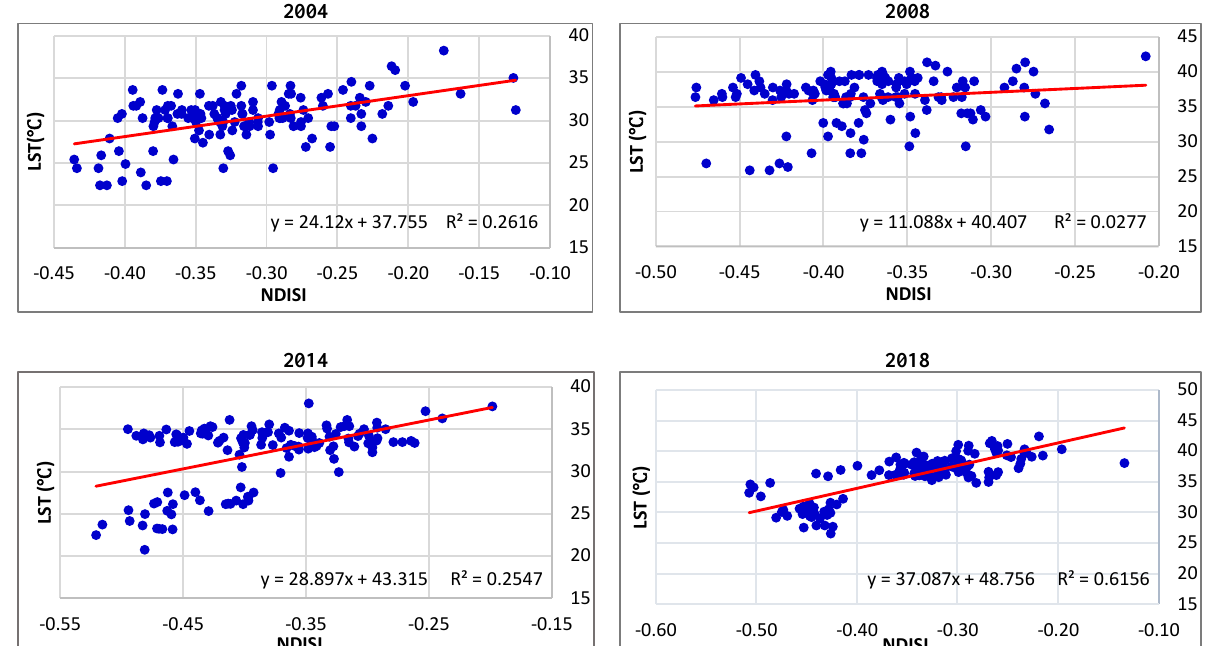
Figure 6. Correlation analysis between LST and NDISI in 2004, 2008, 2014 and